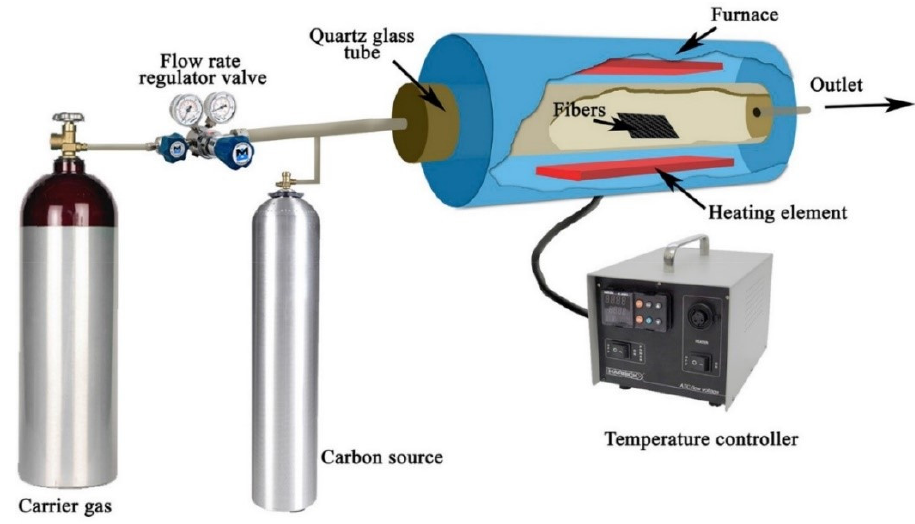
Figure 3. Experimental set-up of Chemical vapor deposition (reprinted with permission) [18].